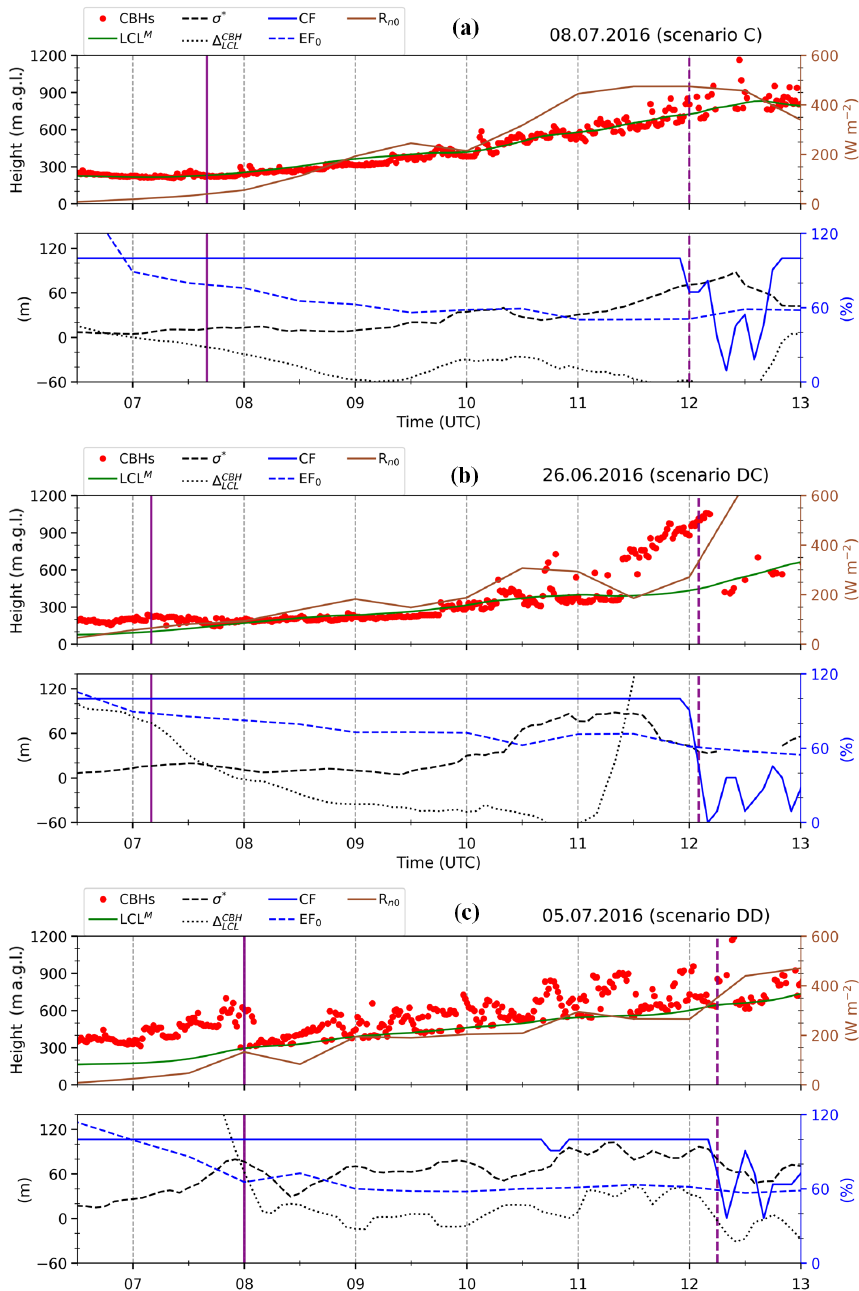
Figure 10. Illustration of the three scenarios of LLSC evolution after sunrise observed at the Savè supersite during the DACCIWA field campaign: (a) 8 July 2016 for scenario C, (b) 26 June 2016 for scenario DC and (c) 5 July 2016 for scenario DD. The top panels present ceilometer-derived CBHs, lifting condensation level (LCL) and net radiation measured at the surface ( R n0 ). The bottom panels gather cloud fraction (CF), evaporative fraction at the surface (EF 0 in %), standard deviation of the cloud base height in the LLSC layer ( σ ∗ ) and mean distance between cloud base height and surface-based LCL ( (cid:49) CBH ). The vertical solid and dashed lines indicate the surface-convection LCL influence time ( T i ) and the LLSC deck breakup time ( T b ), respectively. The local time at Savè, Benin, is UTC +